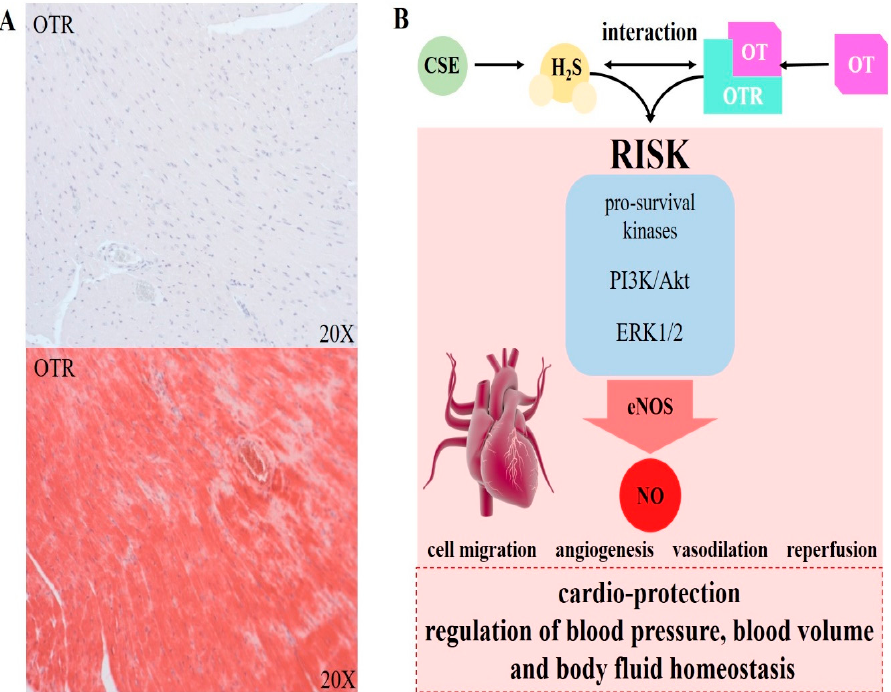
Figure 3. Interaction of H 2 S and OT in the heart. ( A ): Immunohistochemical staining of OTR in heart tissue in a CSEko heart ( n = 3, top) and a wild-type heart ( n = 3, bottom). Heart samples were obtained from naïve animals, which were anesthetized with sevoflurane and buprenorphine and sacrificed via exsanguination (as previously described in [19]). Expression of OTR was absent in CSEko heart and clearly visible in wild-type myocardial tissue. ( B ): The physiological basis of the interaction of CSE and the OTR, converging in the reperfusion injury salvage kinase (RISK) pathway. H 2 S, mainly produced by CSE in the cardiovascular system, and the OTR, stimulated by OT, can both activate the RISK pathway. RISK activation leads to PI3K, protein kinase B (Akt), ERK1/2 cascades and endothelial nitric oxide synthase (eNOS) activation, and promotes reperfusion by stimulating cell migration, angiogenesis and vasodilation, resulting in cardio-protection, regulation of blood pressure, blood volume and body fluid homeostasis. The illustration of the heart was taken from the Library of Science and Medical Illustrations (somersault18:24, https://creativecommons.org/licenses/by-nc-sa/4.0/).